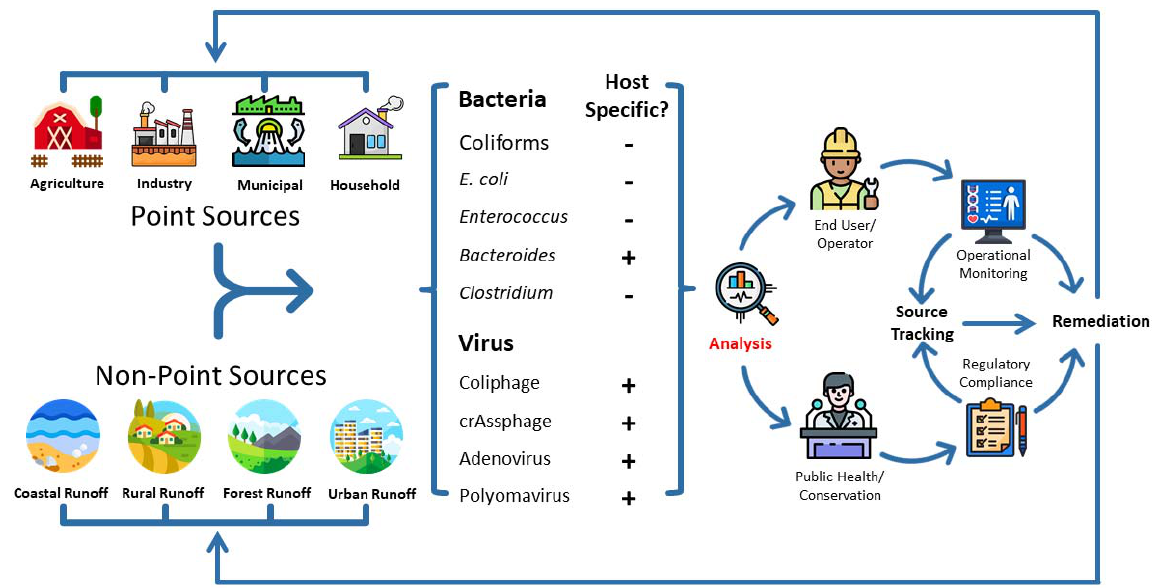
Figure 1. Relationship between the use of selected microbial markers, potential monitoring sites, and diagnostic information by process operators and regulators. Use of these biological markers can facilitate actionable remedial measures by public health officials.